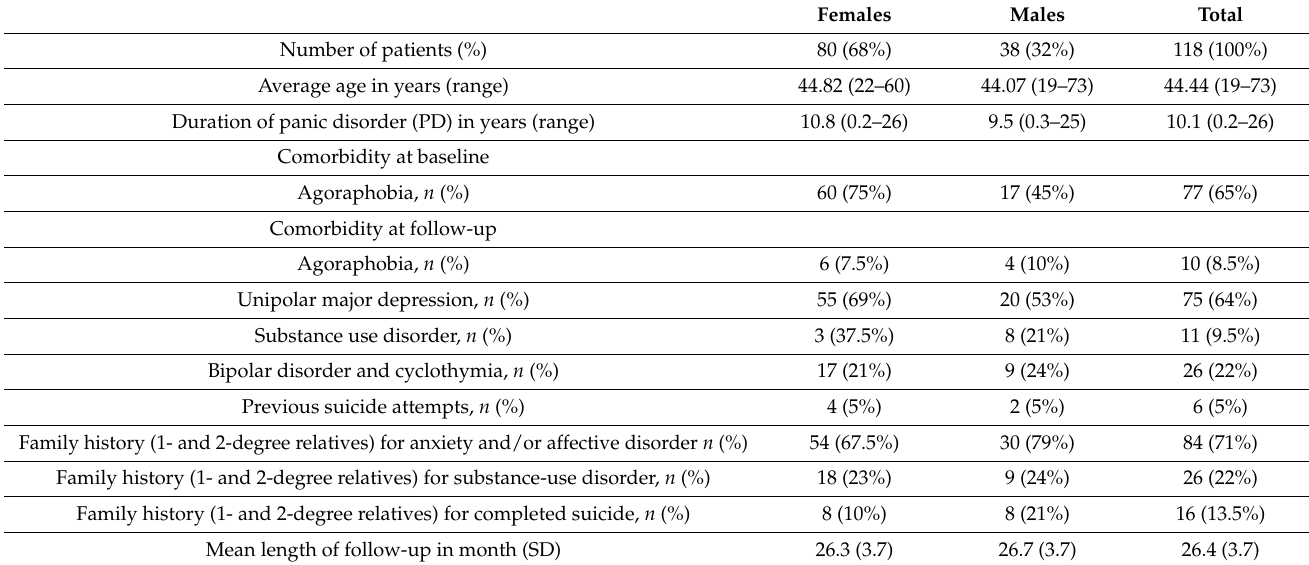
Table 1. Demographic, clinical and family history data of our 118 panic disorder outpatients.